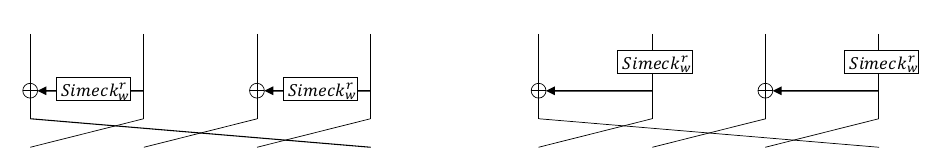
Figure 1: Step Function of sLiSCP (left) and sLiSCP-light (right) Permutations. Simeck r denotes r -rounds of w -bit block